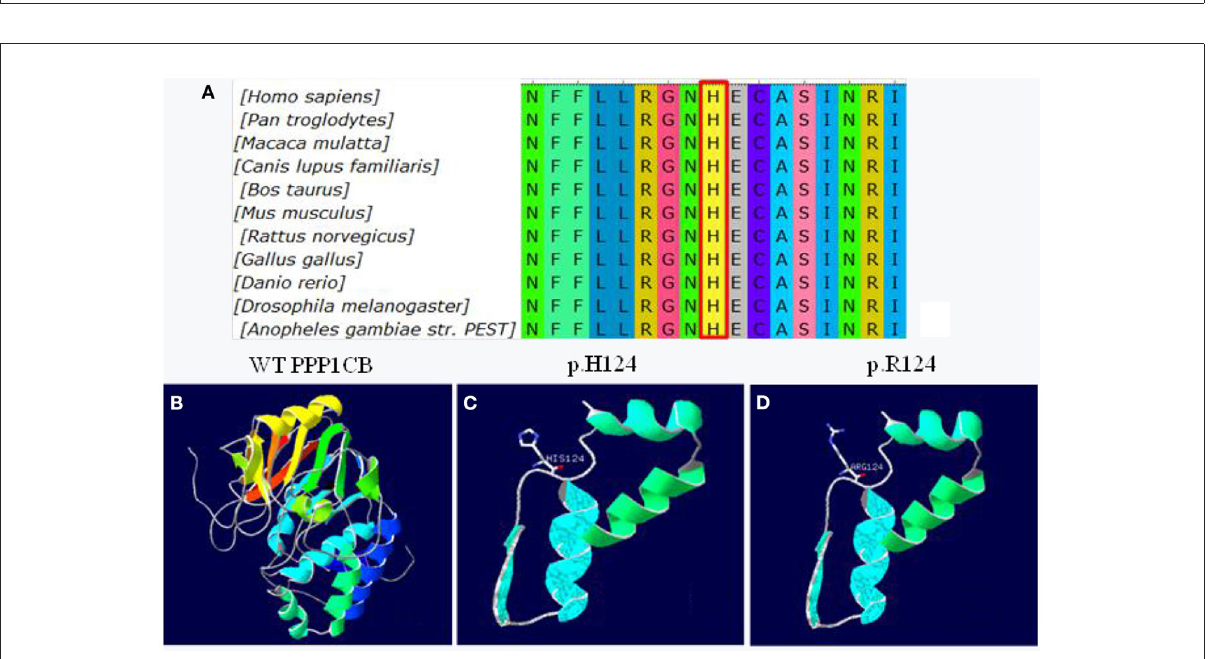
FIGURE5 Conservation and 3D molecular model of PPP1CB mutations. (A) Protein alignment showing PPP1CB p.H124 occurred at evolutionarily conserved amino acids (in red box) across 11 genera; (B) Wild type of PPP1CB ; (C) Three-dimensional molecular models of wild-type protein at site p.H124; (D) Abnormal structure of mutant-type